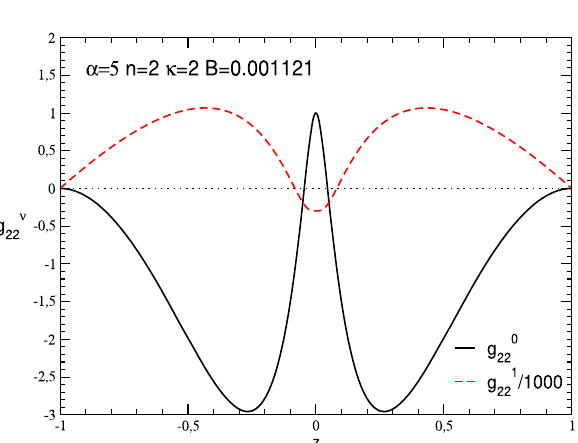
Fig. 5 Components g 0 1